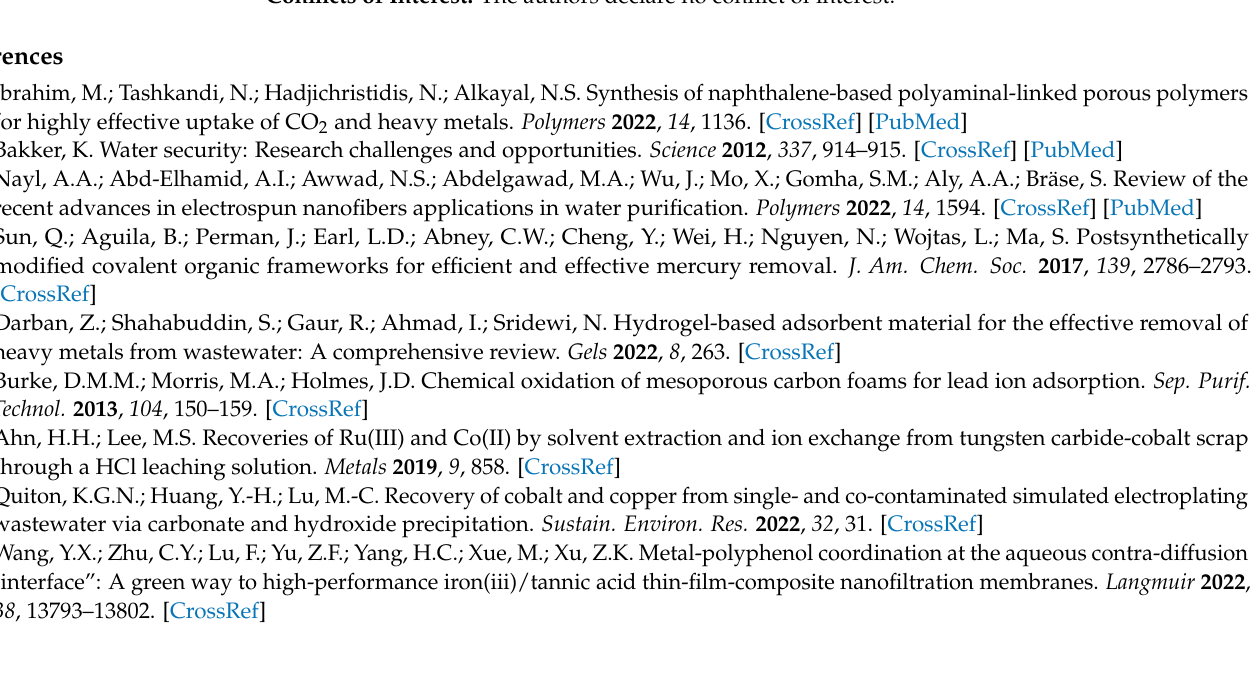
Figure S4: Cycling removal efficiency of Pb 2+ on NUT-21-TETA (C 0 = 100 mg/L, m = 50 mg, V = 10 mL, T = 25 ◦ C); Figure S5: Adsorption performance of NUT-21-TETA for different metal ions (C 0 = 100 mg/L, m = 50 mg, V = 10 mL, T = 25 ◦ C); Figure S6: (a) Breakthrough test set-up, (b) breakthrough curves of the model aqueous solution containing 500 mg/L Pb 2+ /Ni 2+ (50/50, n/n) over NUT-21-TETA; Table S1: Langmuir model parameters for the Pb 2+ uptake on NUT-21- TETA and NUT-21; Table S2: Comparison of the adsorption performance for different adsorbents; Table S3: Pseudo-second-order kinetic model parameters for the Pb 2+ uptake on